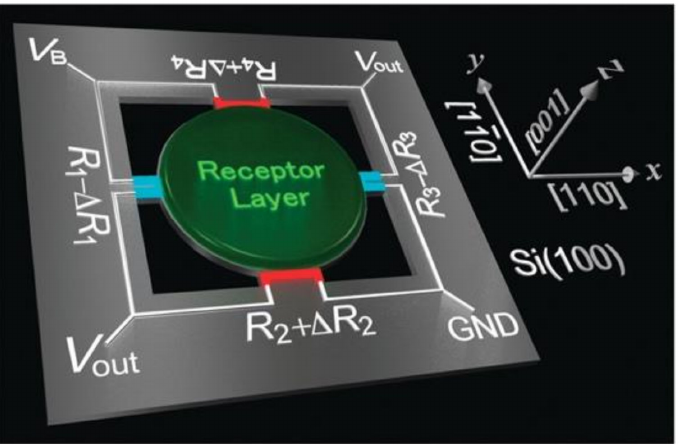
Figure 9. Schematic illustration of MSS with p -type piezoresistors on n -type single crystal Si(100). In this configuration with current flowing in x -direction, blue ( R 1 and R 3 ) and red ( R 2 and R 4 ) colored piezoresistors give opposite signs in ∆ R i / R i in response to the surface stress induced on the adsorbate membrane. Reprinted with permission from Ref. [38]. Copyright 2012, American Chemical